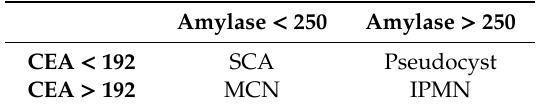
Table 1. Cyst type di ff erentiation by carcinoembryonic antigen (CEA) and amylase levels [29,32].